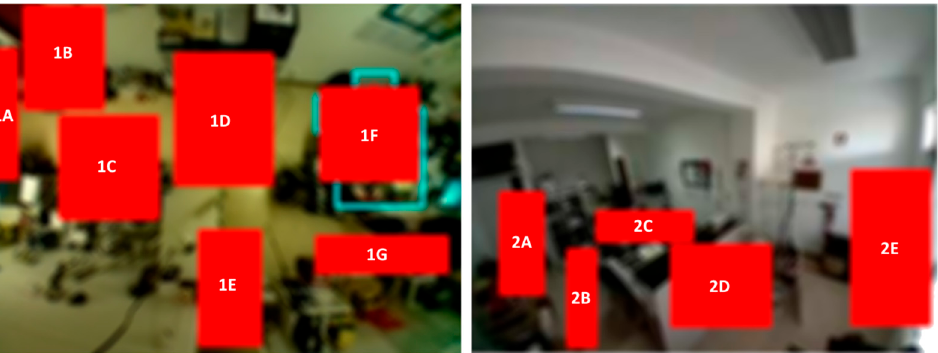
Figure 10. Two zones and several subzones defined for the prototype.